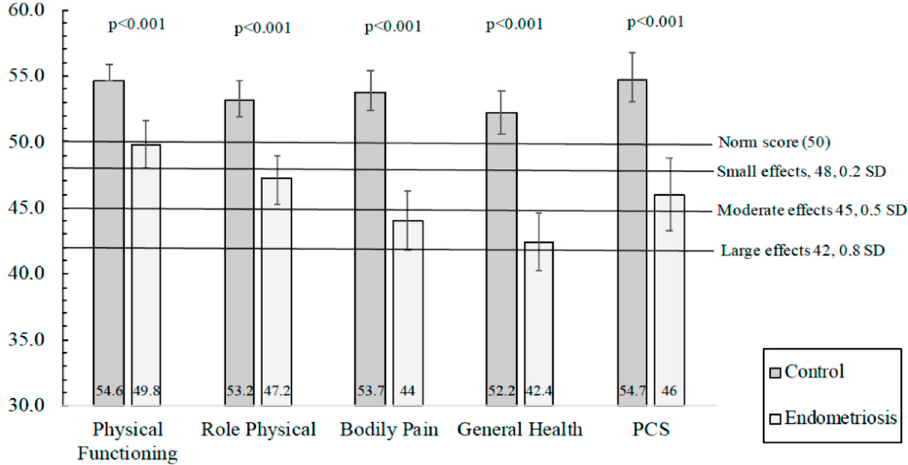
Figure 1. Adjusted means and 95% CI of the four scales and the Physical Component Summary (PCS) of the SF-12v2 questionnaire. The model was adjusted by age, educational level, marital status, infertility problems, and current occupation (ANCOVA).